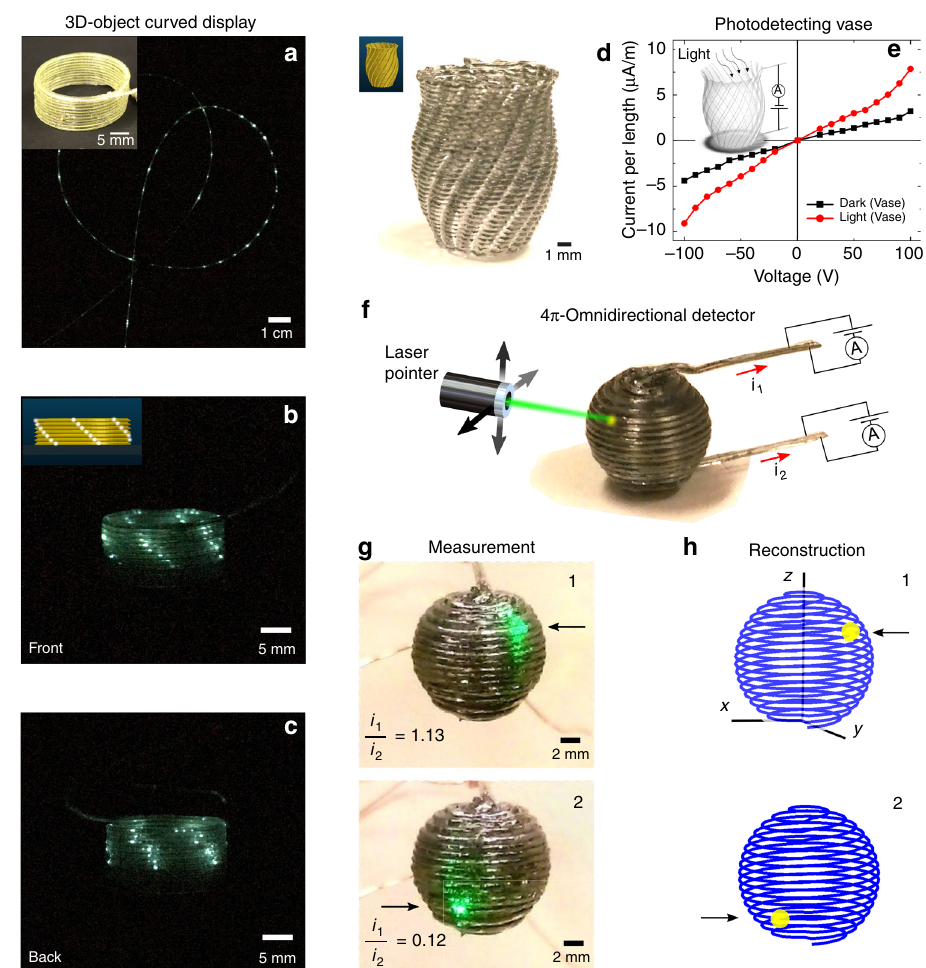
Fig. 4 Three-dimensional printed displays and sensors. a Photograph of a fi lament dotted with 90 pixelated light emitters. The inset shows the cylinder printed from this fi lament, which is capable of b , c displaying electrically-activated stripe patterns all around its body. The inset of b shows the desired light design. d A patterned vase, designed as stacked layers of serpentines, is printed from the light-detecting fi lament and is capable of e detecting light and producing photocurrent from its entire structure when impinged with light. The design fi le for the patterned vase is from Hakalan at Scripted Vases (https://www.thingiverse.com/thing:104694) under the CC BY 3.0 license: https://creativecommons.org/licenses/by/3.0/. f A printed sphere with the ability for omnidirectional localized-sensing anywhere on its surface. To test its detecting accuracy, a low-power laser pointer shines at g different points (1 and 2) on the sphere, producing distinct current ratios (i 1 /i 2 ) which allows for h exact imaging and reconstruction of the laser spots. All connections for the light-detecting macrostructures are made across opposite CPE